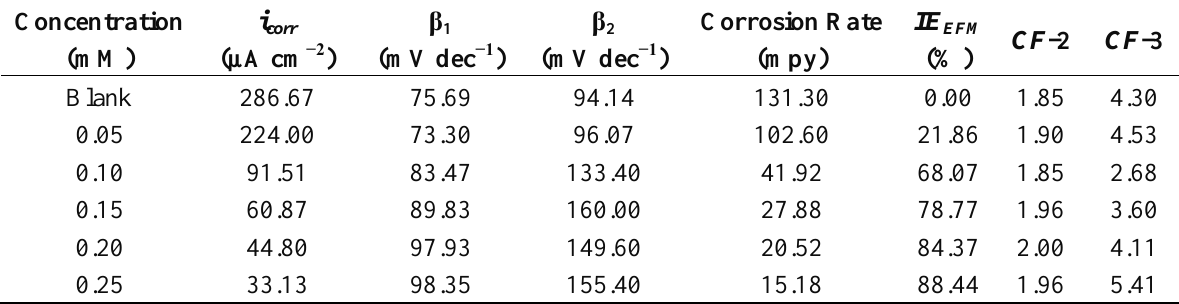
Table 6. Electrochemical frequency modulation (EFM) electrochemical parameters for mild steel in 1.0 M H SO with different concentrations of the corrosion inhibitor at 30 °C. 2 4 i , current density; β , Tafel slope; CF , causality corr N